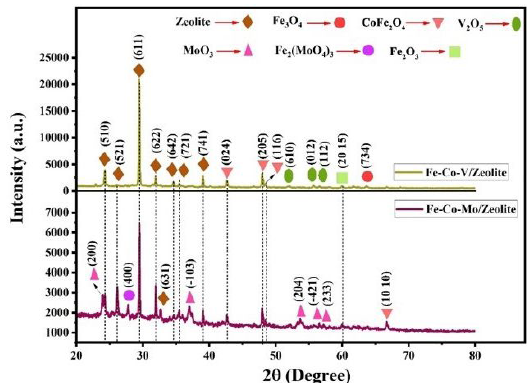
Figure 1. XRD spectra of Fe-Co-V/Zeolite and Fe-Co-Mo/Zeolite CNs.